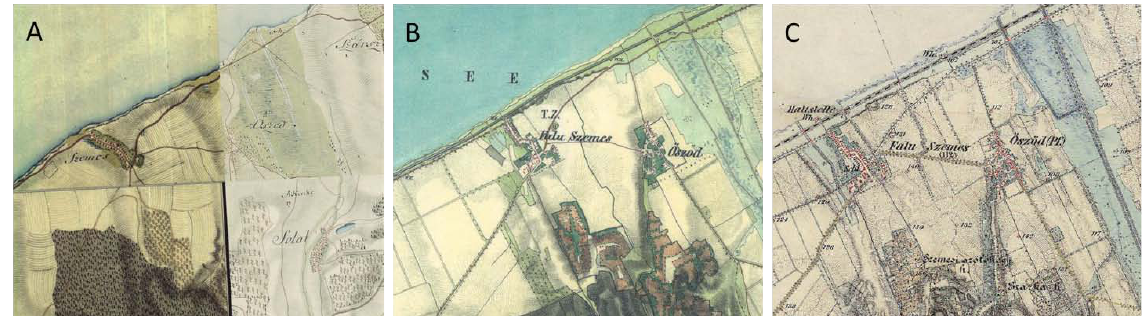
Fig. 3. Cutouts of the same area in the First (a) , Second (b) and Third (c) Habsburg military